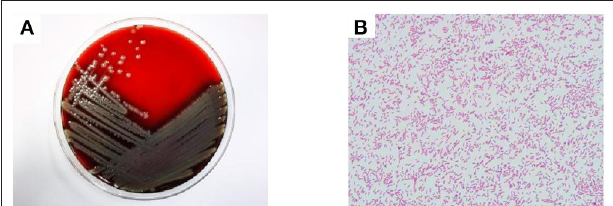
FIGURE 2 | Culture plates showing the growth of Elizabethkingia miricola . The blood plate colony is yellow, translucent, round, with neat edges (A) . Gram-negative bacilli can be seen 1,000 times under the oil lens of blood culture (B) .